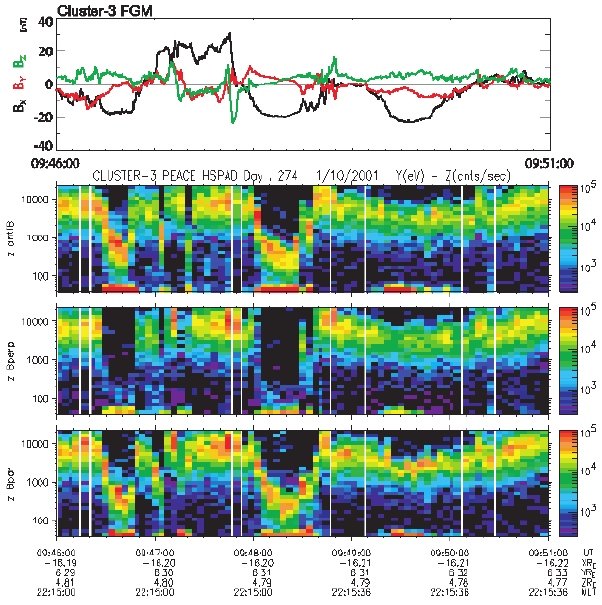
Fig. 15. B x , B y , B z profile (from FGM) and spectrogram show- ing the electron flux (from PEACE), color coded, versus energy and time, for S/C3 during the same time interval as Fig. 14. Time reso- lution is